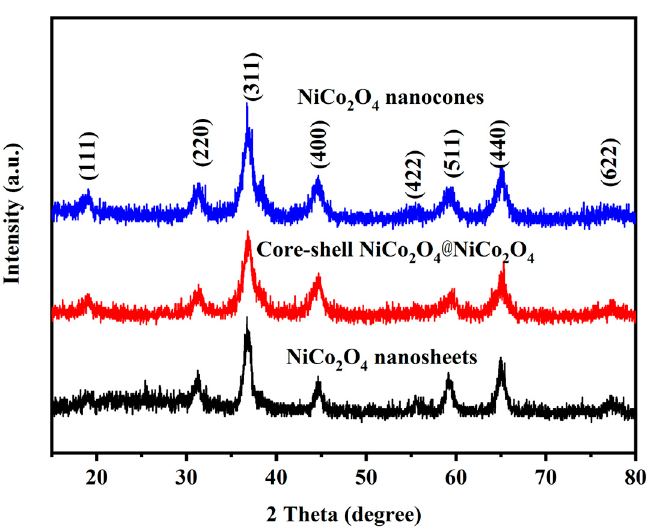
Figure 2. An XRD pattern of the NiCo 2 O 4 nanocones, NiCo 2 O 4 nanosheets and core-shell NiCo 2 O 4 @NiCo 2 O 4